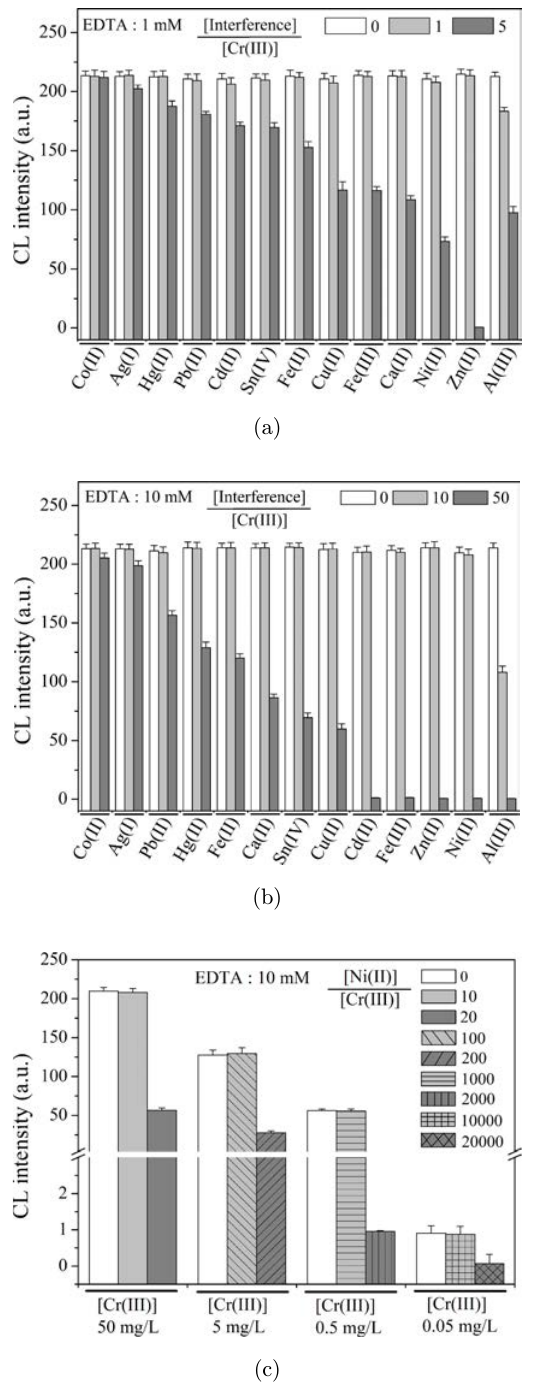
Fig. 7. Evaluation of interferences from coexisting metal ions for Cr(III) determination on the presented devices. In